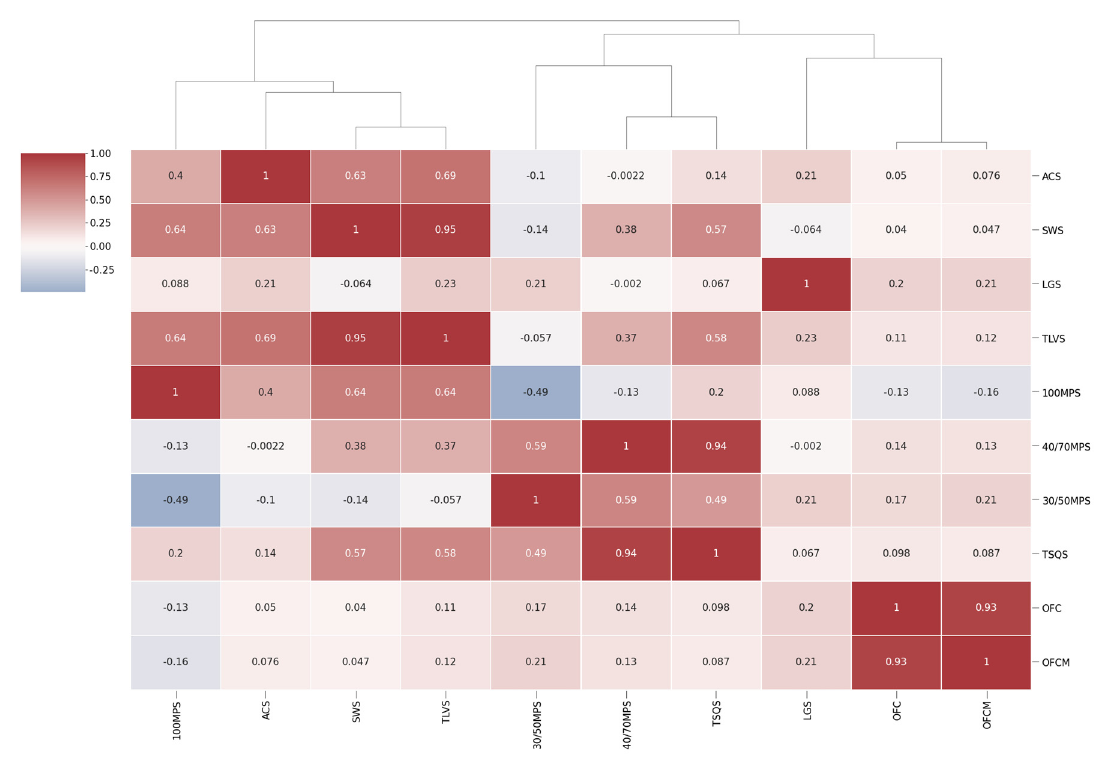
Figure 3. Thermal clustering diagram of horizontal well fracturing construction parameters.